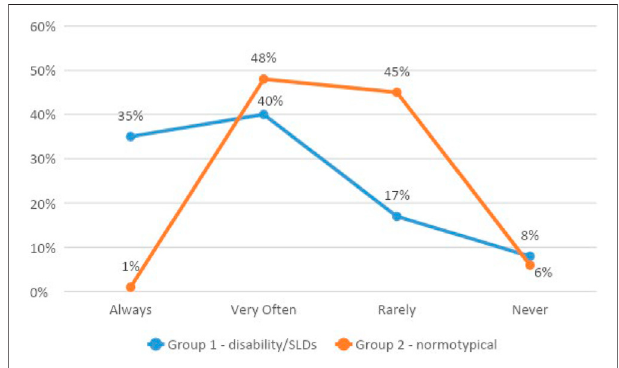
FIGURE 2 | Differences in percentage between groups relative to the item “ Have you felt calm and peaceful? ” .